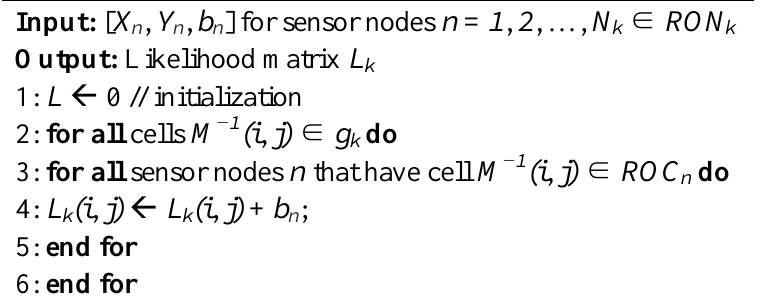
Algorithm 2. Likelihood Matrix Construction.